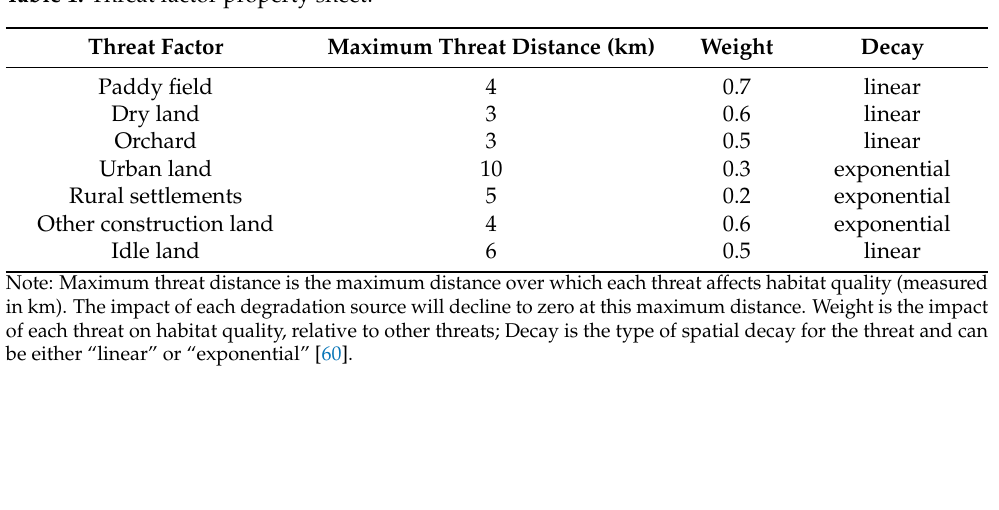
Table 1. Threat factor property